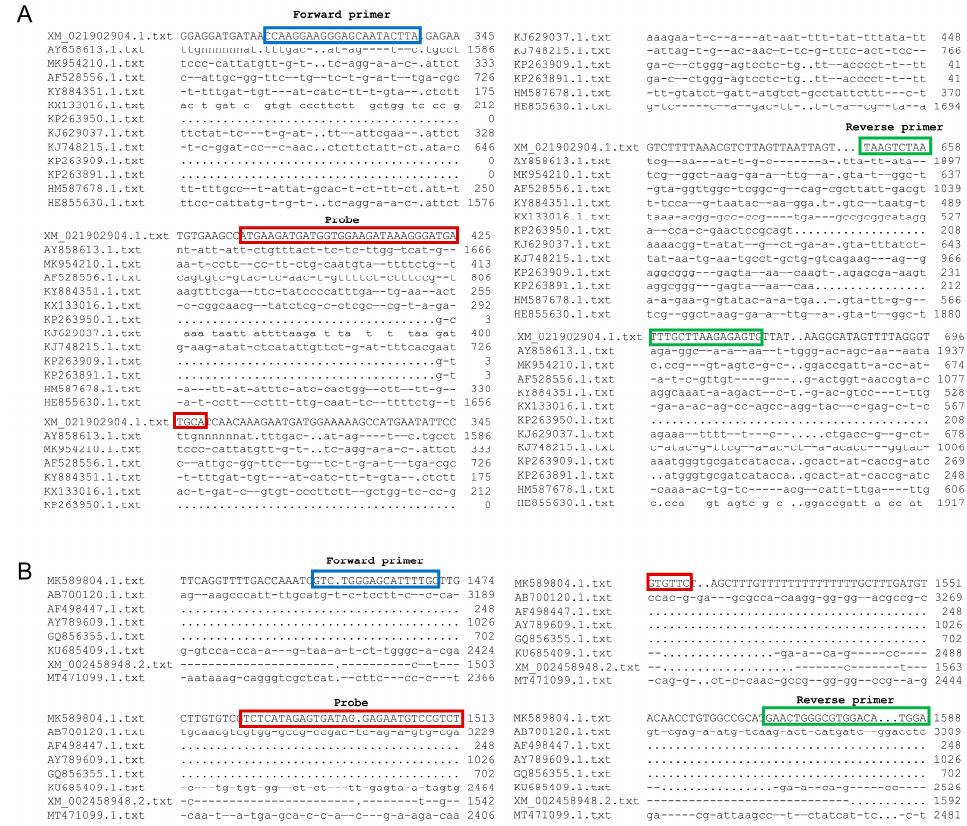
Figure 1. Specific analysis of primer and probe. ( A ) Specificity comparison of primer and probe sequences of the 2S albumin gene region developed for specific qPCR detection of quinoa source component using MEGA 4.0. ( B ) Specificity comparison of primer and probe sequence of SAD gene region developed by specific qPCR detection of coix seed source component using MEGA Table 1. Primers and probes sequence used in this study a .